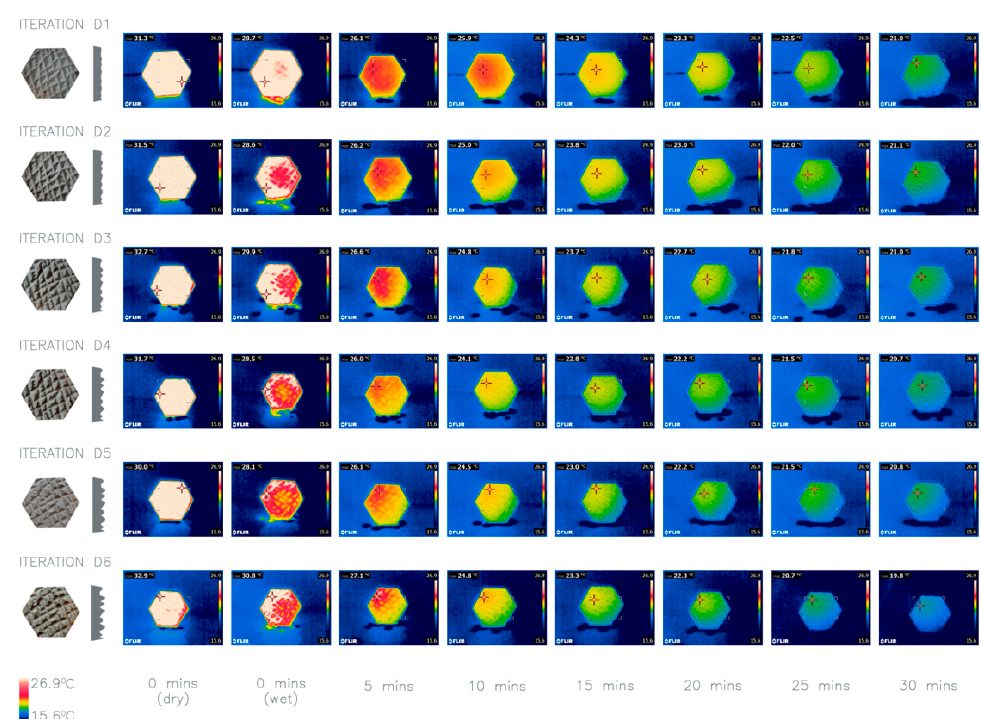
Figure 6. Thermal imaging of investigation 3: comparison of six iterations D1–D6 with different texture depths. Average heat loss after 30 min: D1 7.7 ◦ C, D2 8.36 ◦ C, D3 9.06C, D4 9.16 ◦ C, D5 7.3 ◦ C, D6 9.97 ◦ C.